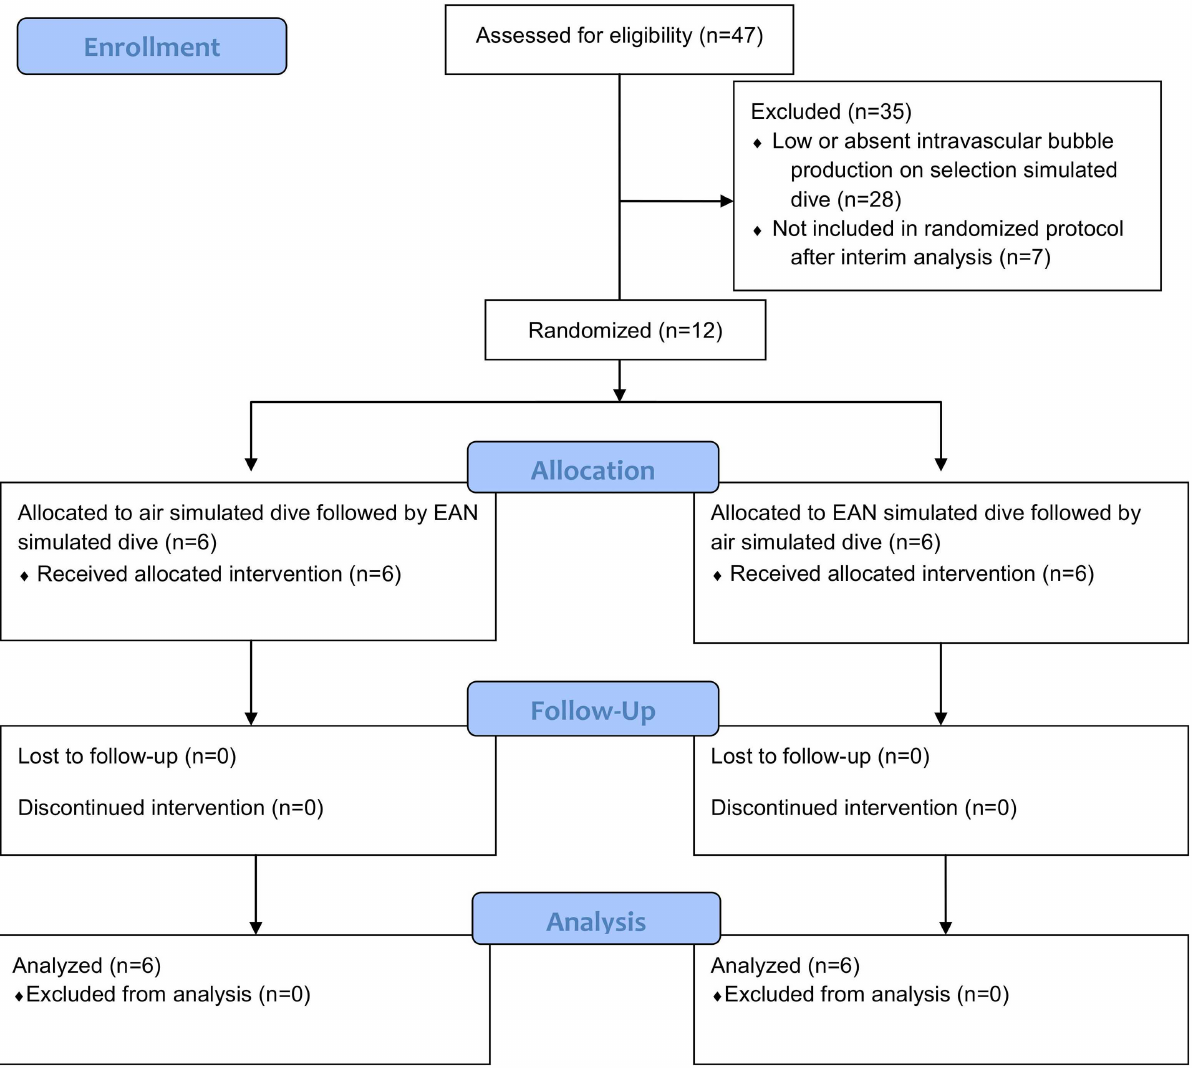
Fig 2. Inclusion and randomization flow diagram. EAN = Enrichedair